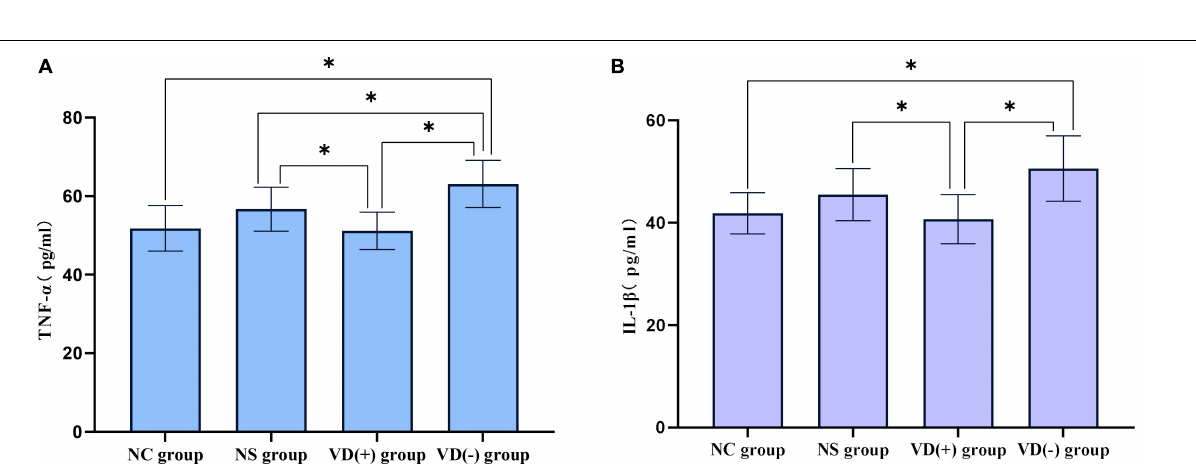
Frontiers in Aging Neuroscience |